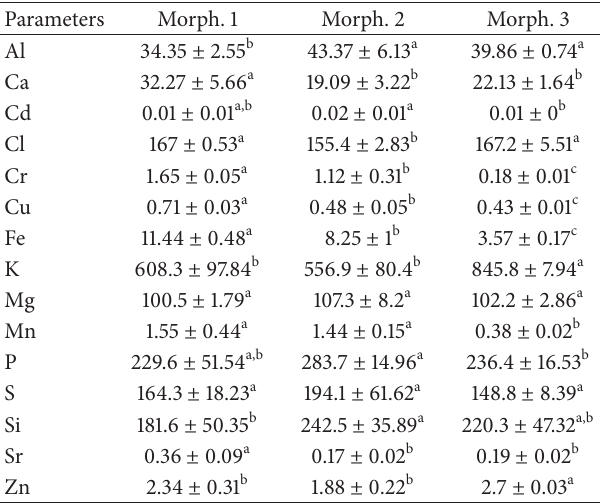
Table 5: Mineral composition (mg 100g − 1 ) of Cyperus esculentus morphotypes